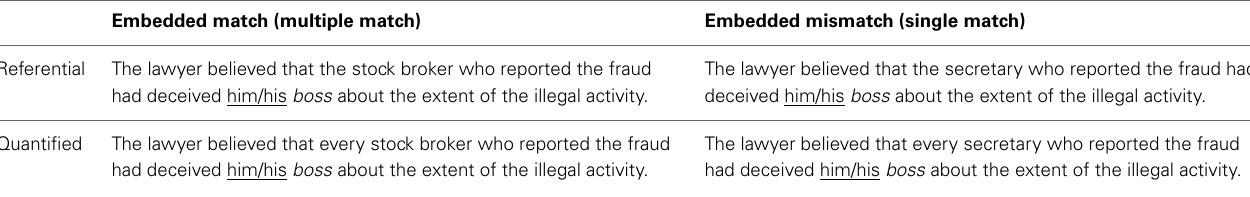
Table 4 | Experimental conditions and sample materials for Experiment 3. Embedded match (multiple